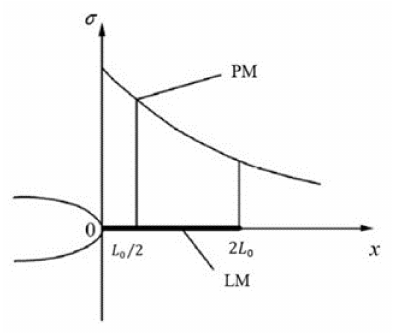
Figure 1. Schematic diagram of point method and line